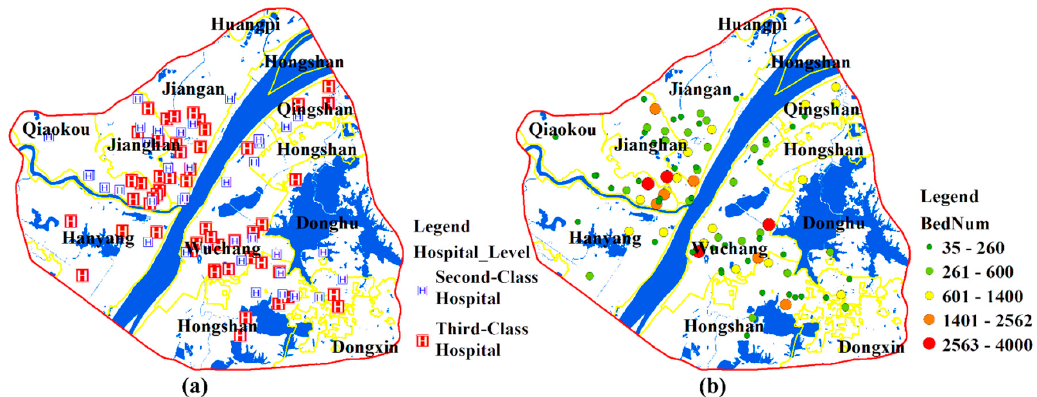
Figure 4. ( a ) A distribution map of the hospitals; ( b ) the distribution of the number of beds.